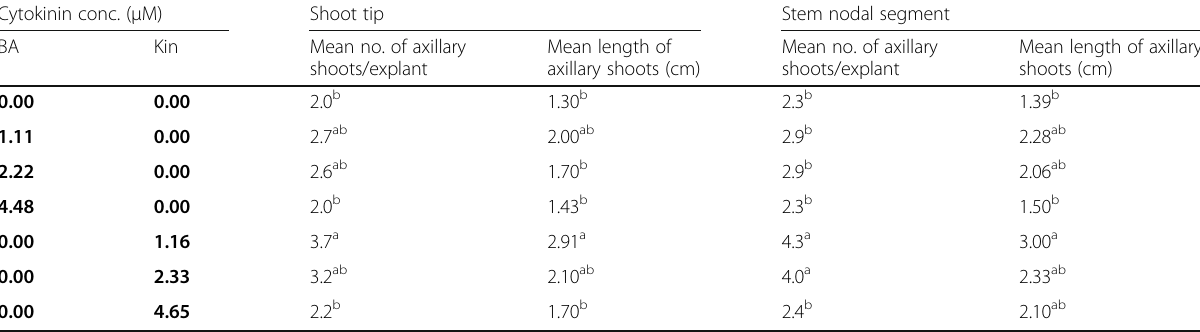
Table 1 Effect of Murashige and Skoog (MS) medium supplemented with 2.89 μ M gibberellic acid (GA 3 ) and 1.08 μ M α - naphthaleneacetic acid (NAA) in addition to 6-benzyl adenine (BA) or kinetin (Kin) on the in vitro establishment of Silene schimperiana shoot tip and stem nodal segment explants. All treatments gave 100% of both survived explants and growth